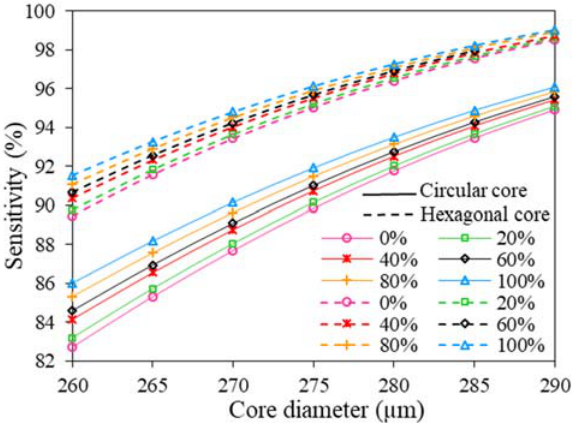
Figure 5. The variation of RS with Dc of hexagonal and circular core at 2 THz.